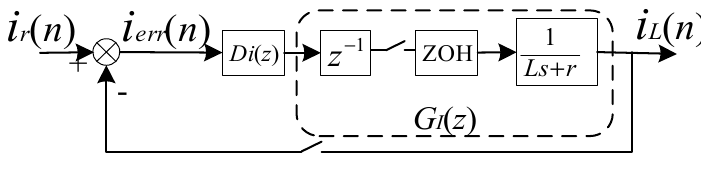
Figure 4. Inverter current loop.